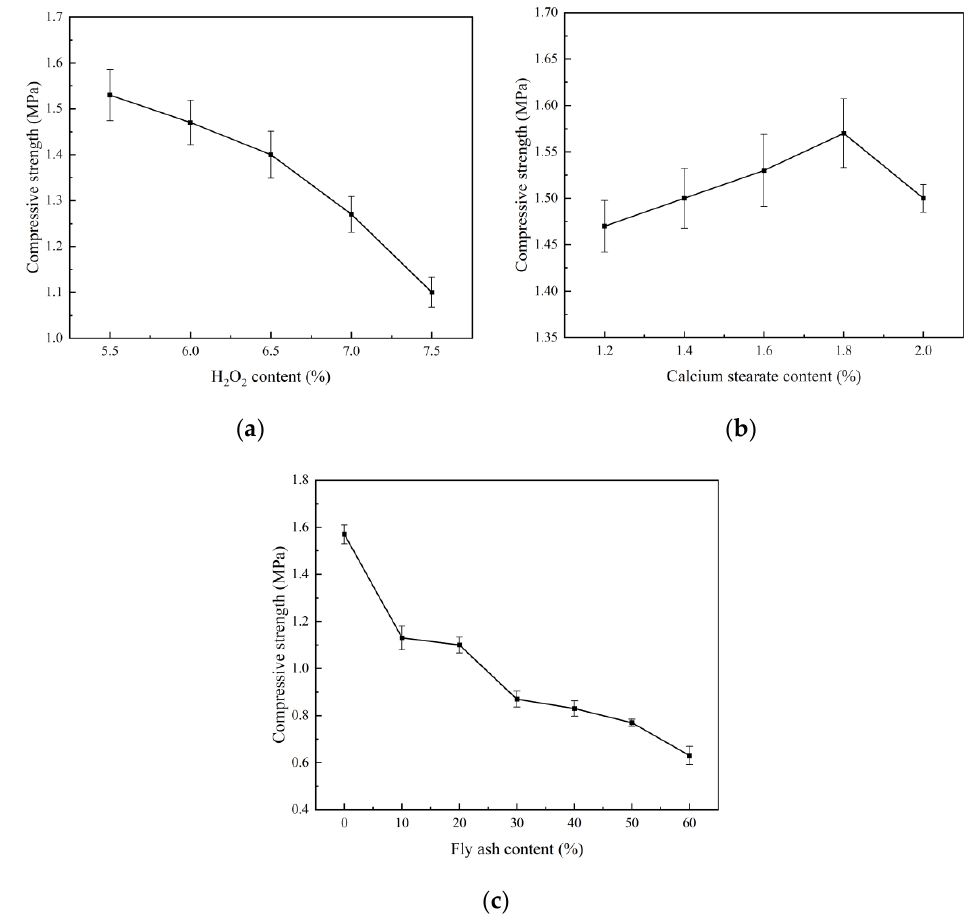
Figure 4. Compressive strength of foam concrete: ( a ) H 2 O 2 content; ( b ) calcium stearate content; ( c ) fly ash content.